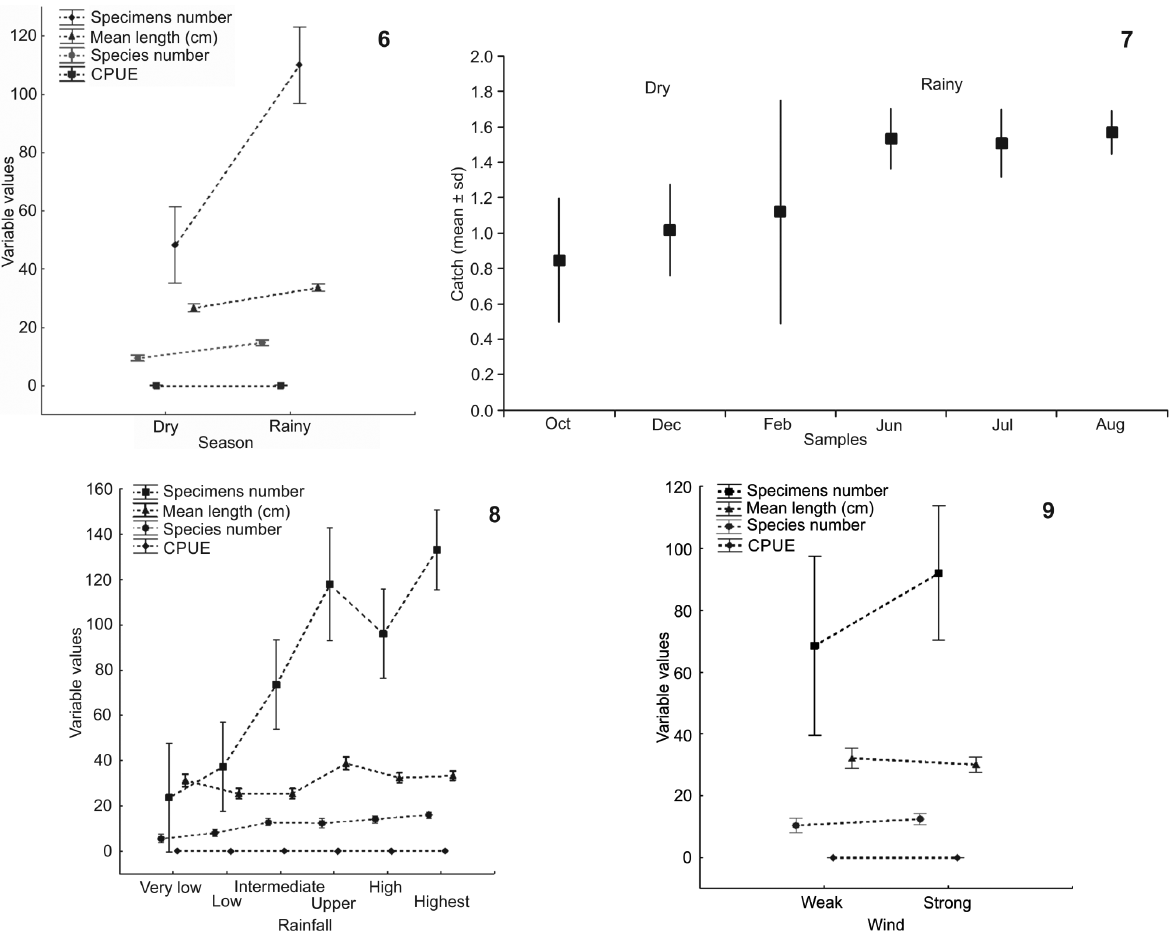
Figures 6–9. Mean ± sd of the number of fishes, fish total length, species richness, and CPUE by climatic seasons ( 6 ); CPUE (mean ± sd) by month ( 7 ); precipitation by month ( 8 ) and wind strength by month ( 9